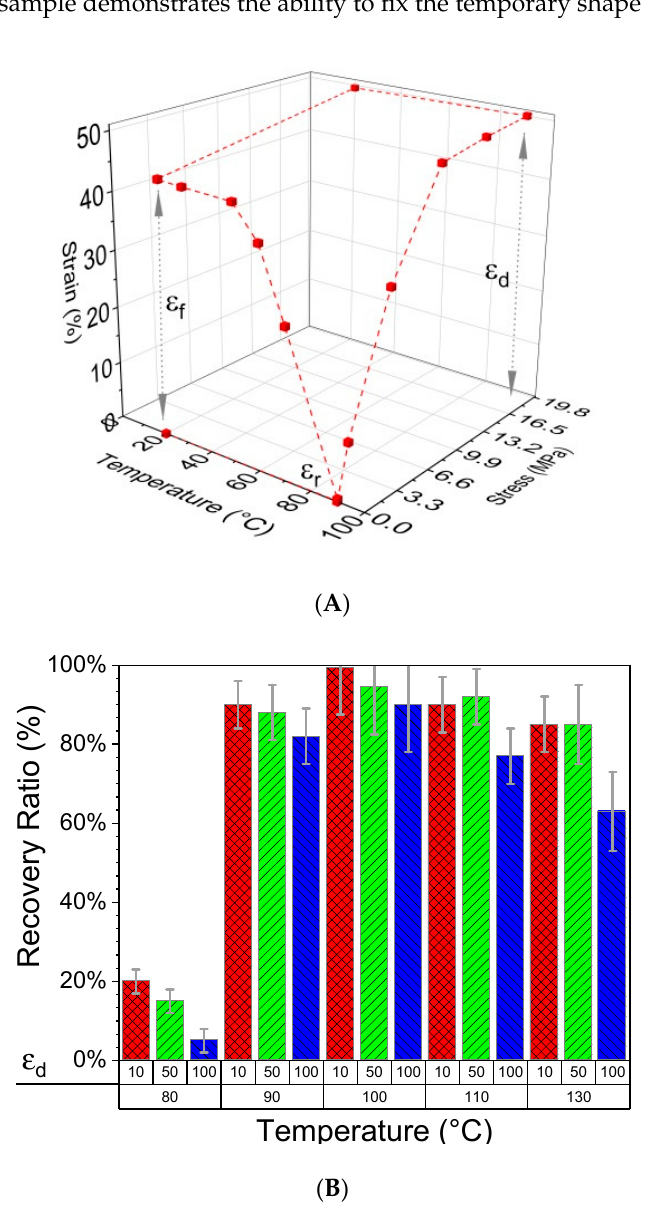
Figure 8. Shape memory tests: ( A ) thermomechanical cycle of Block-L sample ( B ) Recovery ratio as function of temperature and initial strain.